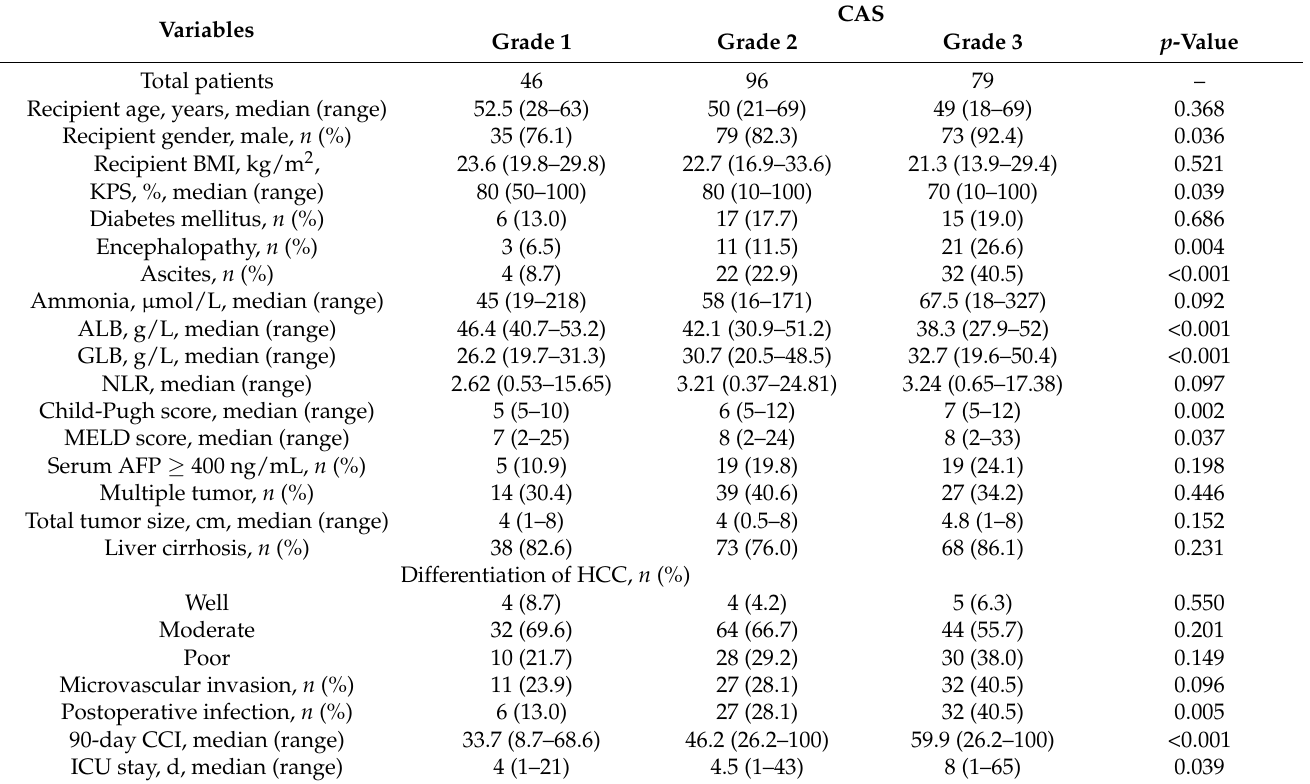
Table 3. Correlation between CAS and clinicopathological characteristics in HCC patients who underwent